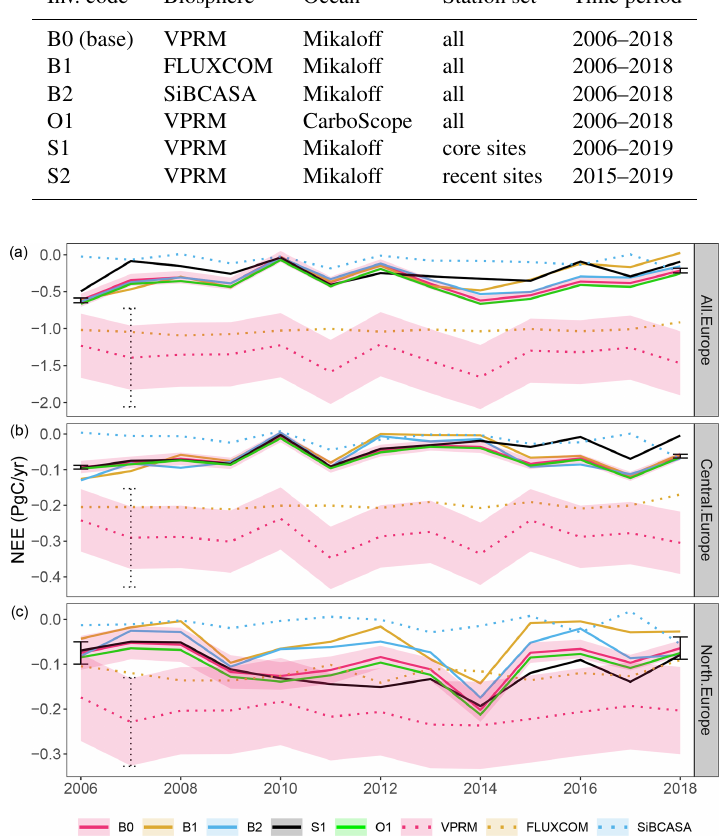
Figure 3. NEE fluxes estimated using B0, B1, B2, S1, and O1 inversions for the 2006–2018 period over the full domain of Europe (a) , Central Europe (b) , and Northern Europe (c) . Posterior fluxes are plotted with solid lines and their a priori fluxes as the dotted lines. Priors and posteriors of the biogenic ensemble are distinguished by identical colours for each modelled scenario. Light red shadowing denotes the statistical uncertainty and error bars indicate the spread among the biosphere inversions’